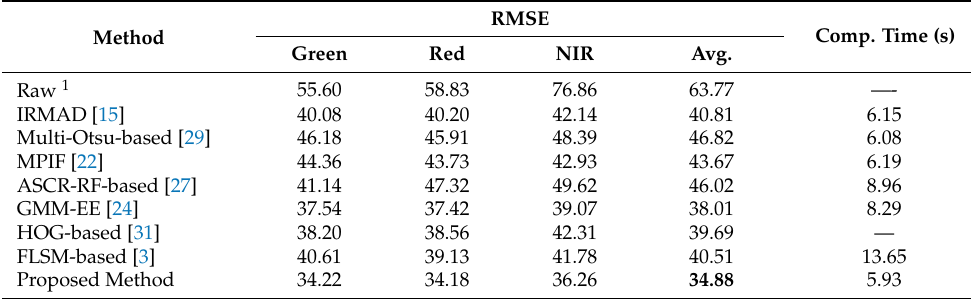
Table 6. Comparison between the accuracy and componential time of different SRRN methods and the proposed methods for simulated dataset